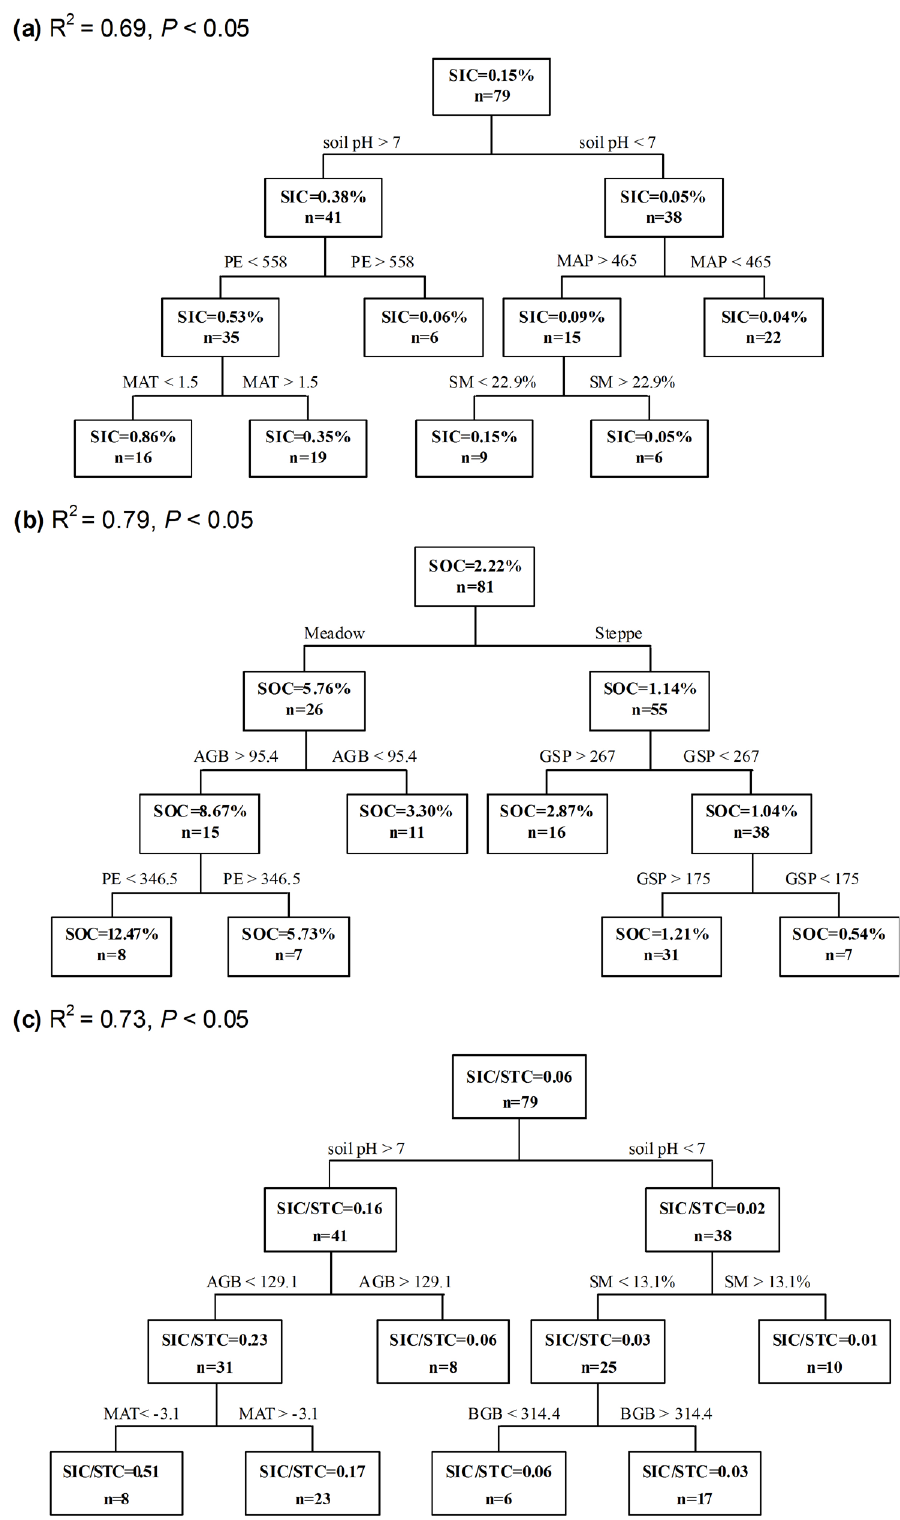
Fig. 3. Classification and regression trees of SIC (a) , SOC (b) , SIC/ STC (c) . Branches are labelled with criteria used to segregate data. Values in terminal nodes represent mean soil SIC (a) , SOC (b) and SIC/STC (c) of sites (0–20cm) grouped within the